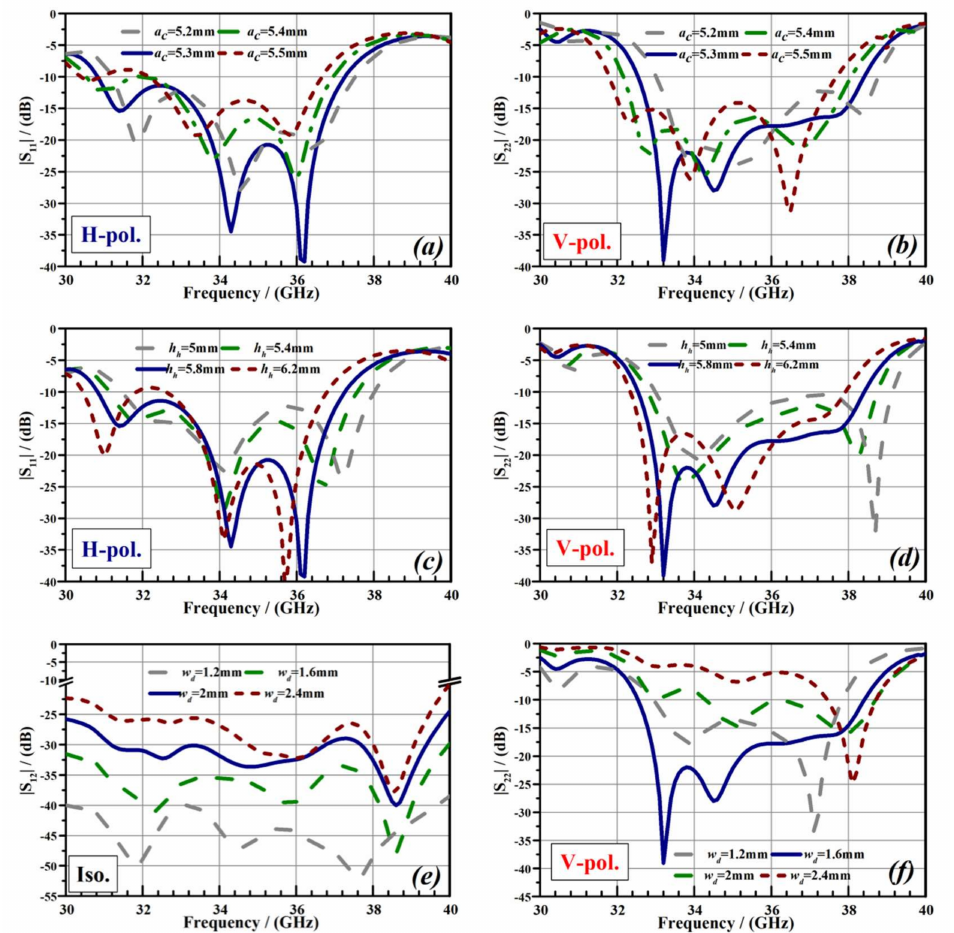
Figure 6. Parameter analysis of the feeding part: ( a , b ) width of square WG; ( c , d ) height of the pyramid horn cavity; ( e , f ) width of the coupling